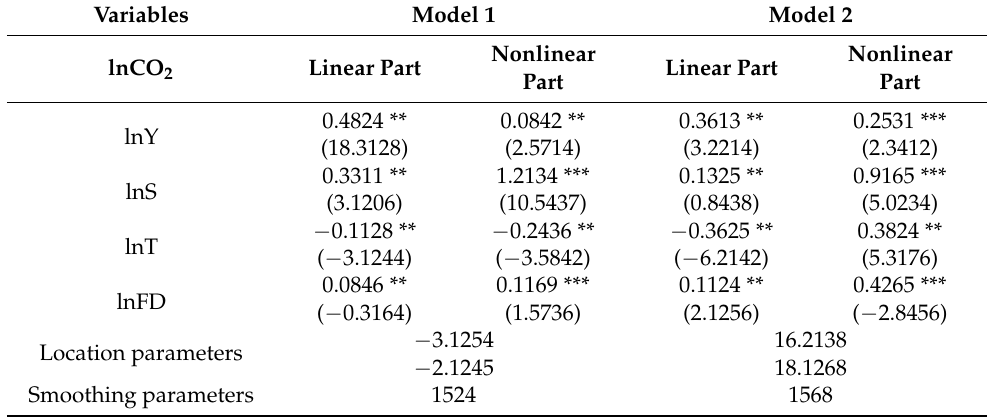
Table 9. Estimated